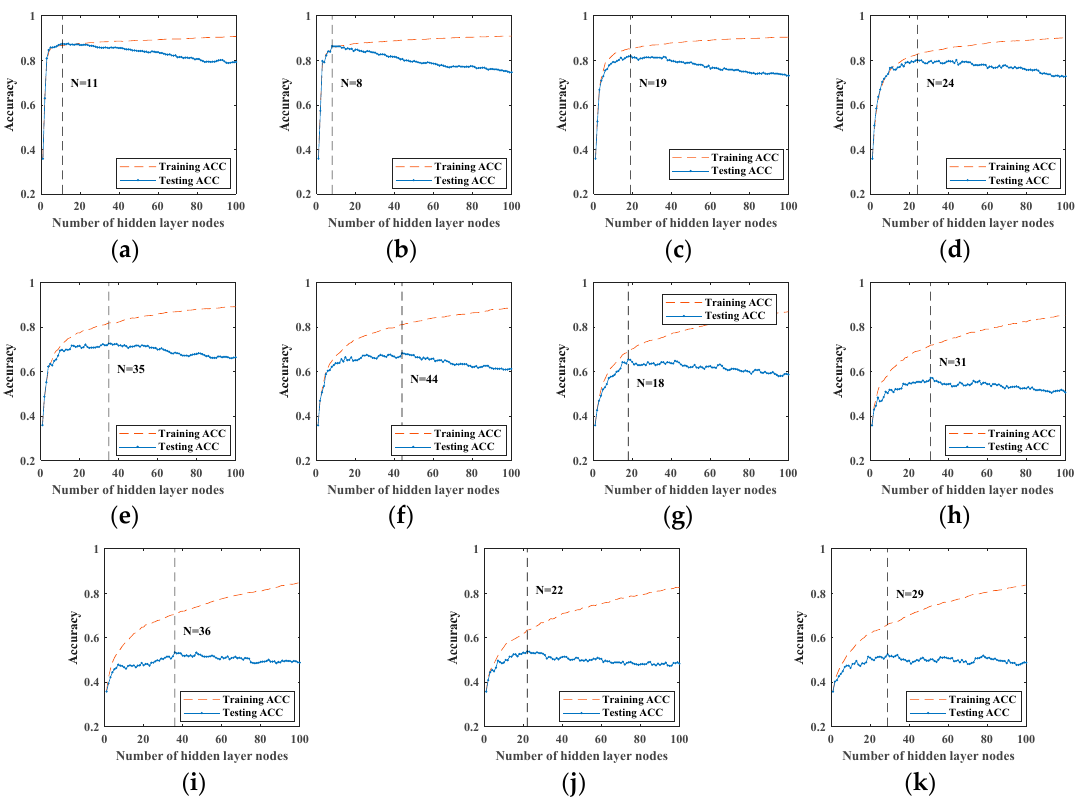
Figure 9. Original SCN’s training and testing accuracy for signals superimposed by white Gaussian noise: ( a ) α G = 0; ( b ) α G = 20; ( c ) α G = 40; ( d ) α G = 60; ( e ) α G = 80; ( f ) α G = 100; ( g ) α G = 120; ( h )